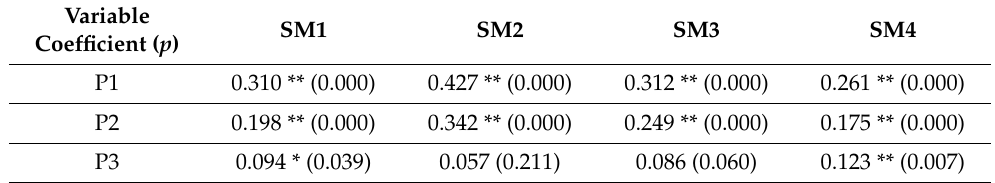
Table 10. Participation vs. Smart Mobility—Pearson correlation